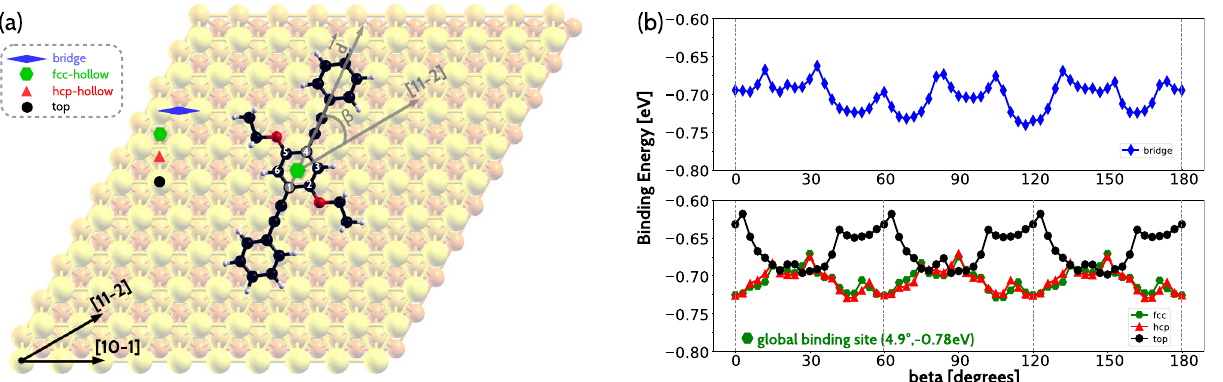
Figure 2. ( a ) Sampling shown for the central phenyl ring placed over an fcc-hollow site: β denotes the in-plane (cid:31) d rotational angle of MB to the [11-2] direction. The vector defining the MB-direction is spanned between the ◦ carbon atoms 1 and 4 of the central phenyl ring. β has the value 0 , if the molecular backbone is oriented parallel to the [11-2] direction. The bridge-, fcc-, hcp-, top-sites are shown using blue skewed diamond, green hexagon, red triangle and black circle, respectively. There is an atom directly beneath the third (second) layer below the fcc (hcp) hollow site, respectively. ( b ) Binding energies: The configurational spaces bridge-ms, fcc-ms, hcp-ms, and top-ms are denoted using blue, green, red, and black curves, respectively. fcc-ms, hcp-ms and top-ms curves reflect a three-to-six-fold rotational symmetry, whereas bridge-ms does not show any additional symmetry ◦ ◦ between 0 and 180 , as strate equals 0.14 | e | , which excludes the possibility of intermolecular Coulomb interaction. Furthermore, the charge re-distribution for the molecule occurs predominantly along the side chains (SCs) and the outer phenyl ring (OPR), which is not perturbed significantly upon adsorption. An overall dipole moment is prohibited by the presence of an inversion center. Thus, a possible clustering of PEEB molecules would be driven by interactions between partial-charge centers. High‑throughput calculations: clustering. In order to explain the clustering of PEEB molecules on Au(111) we propose an energy function incorporating two concurrent yet independent processes: (a) a Surface Binding Energy, which describes the adsorption of single PEEB molecules on Au(111) on a chosen site and (b) a Planar Clustering Energy, which takes into consideration the intermolecular interactions solely between two isolated PEEB molecules. We define the sum of both energies as total energy E tot . We sample the configurational space in search for the most likely interlocking patterns in two steps: At first, we determine the energy landscape of the binding process of a single molecule on the surface. For that, we place an isolated PEEB molecule over Au(111) with the central phenyl ring (CPR) aligned over a high-symmetry site at ◦ the Au surface. The in-plane rotation angle β of the start configuration is choosen as 0 , when the molecular back- bone (MB) is parallel to the [11-2] direction of the Au(111) surface, see Figure 2(a). Subsequently, β is increased ◦ ◦ to 180 in steps of 3 , while keeping the center of the CPR aligned to the chosen adsorption site. As the molecule